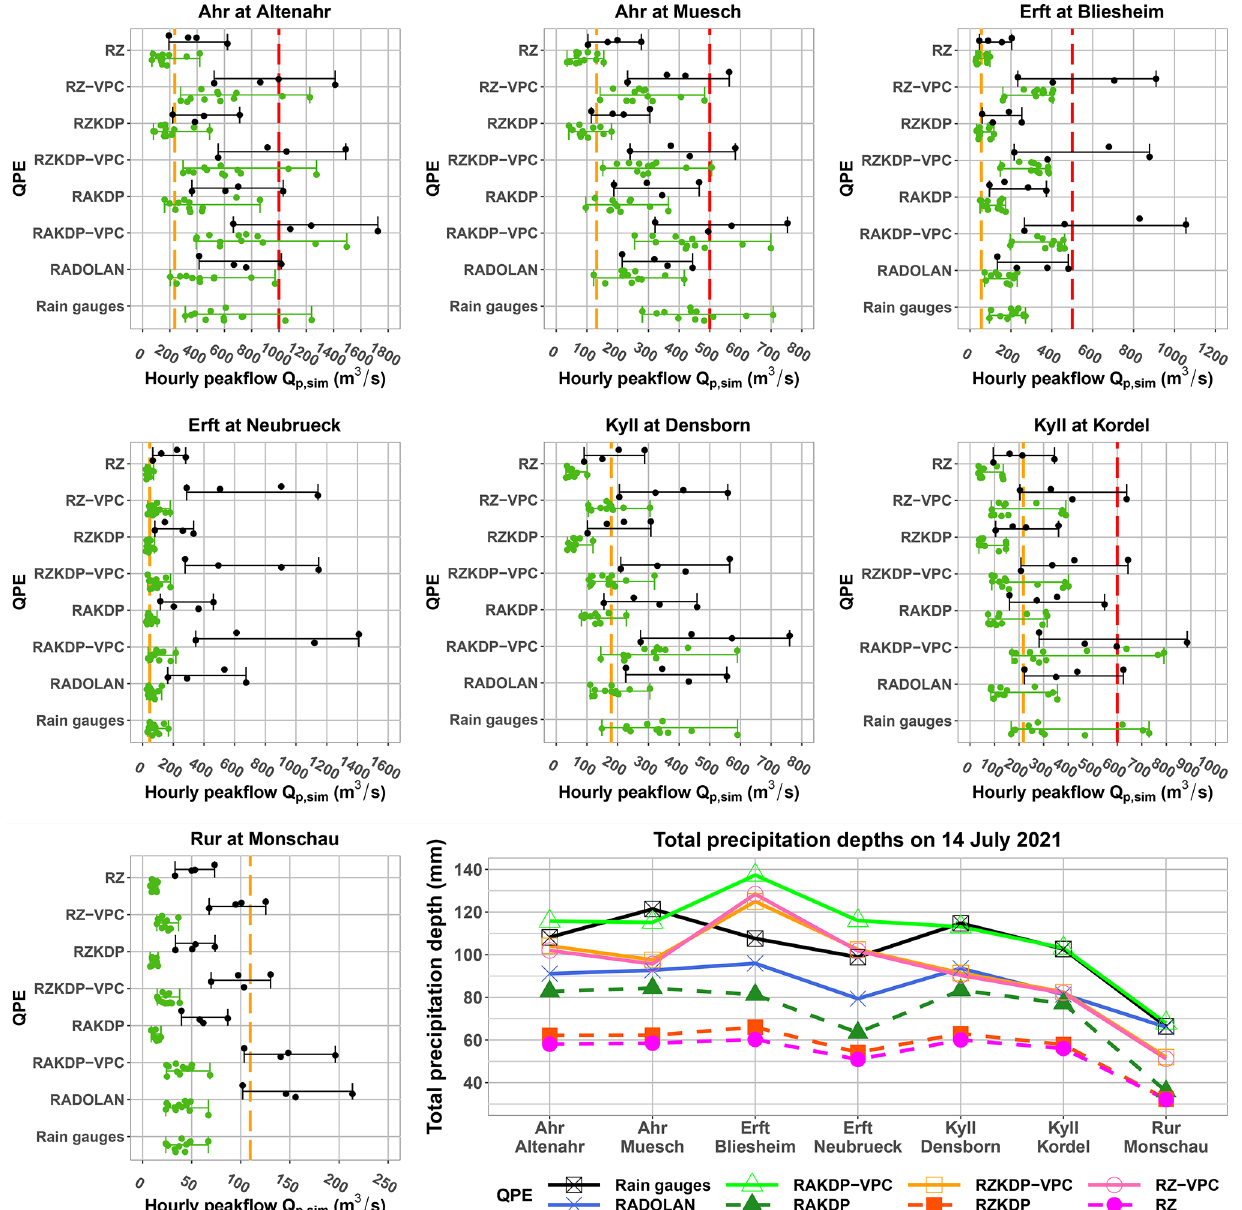
Figure 6. Distributions of simulated peak flows by GR4H (in green) and ParFlowCLM (in black) using eight QPE inputs (on y axis) for the seven catchments. Dashed orange lines indicate the highest measured peak flow before July 2021. When available, dashed red lines indicate the peak flow estimates based on relationships between water level depths and discharge taken from Mohr et al.